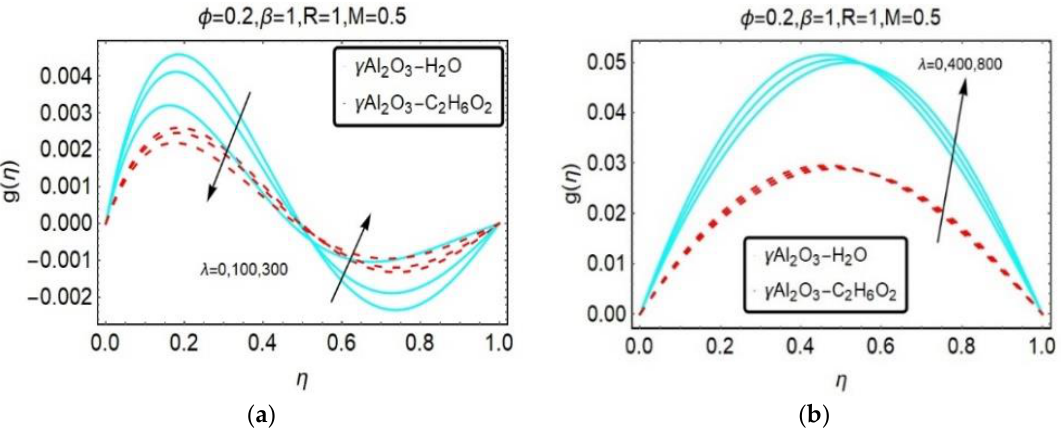
Figure 14. Influence of 𝜆 on 𝑔(𝜂) for ( a ) 𝑆 > 0 and ( b ) 𝑆 < 0.